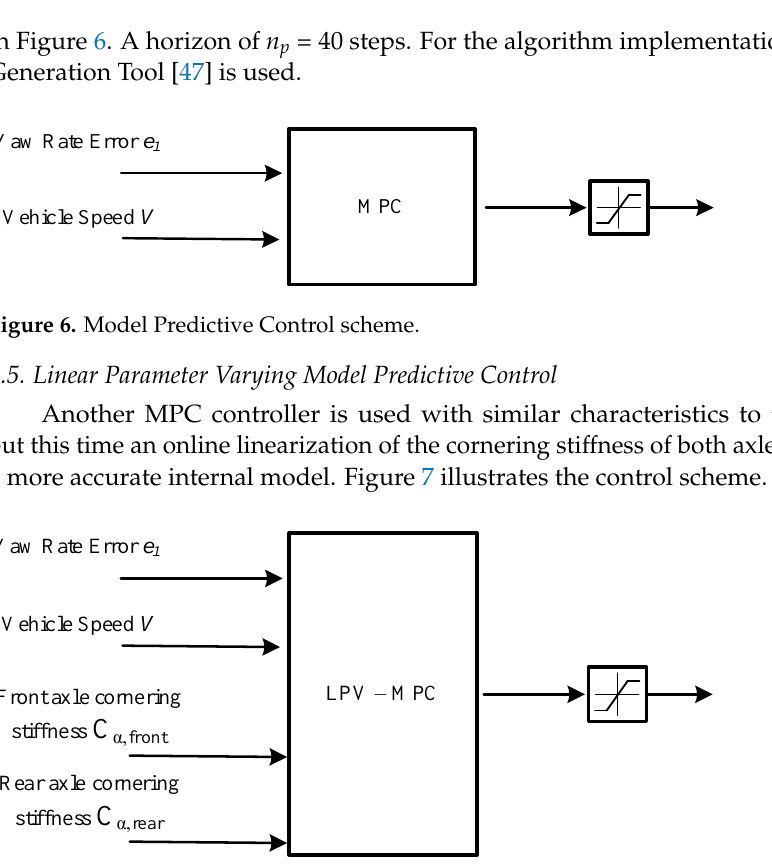
Figure 7. Linear Parameter Varying Model Predictive Control scheme.